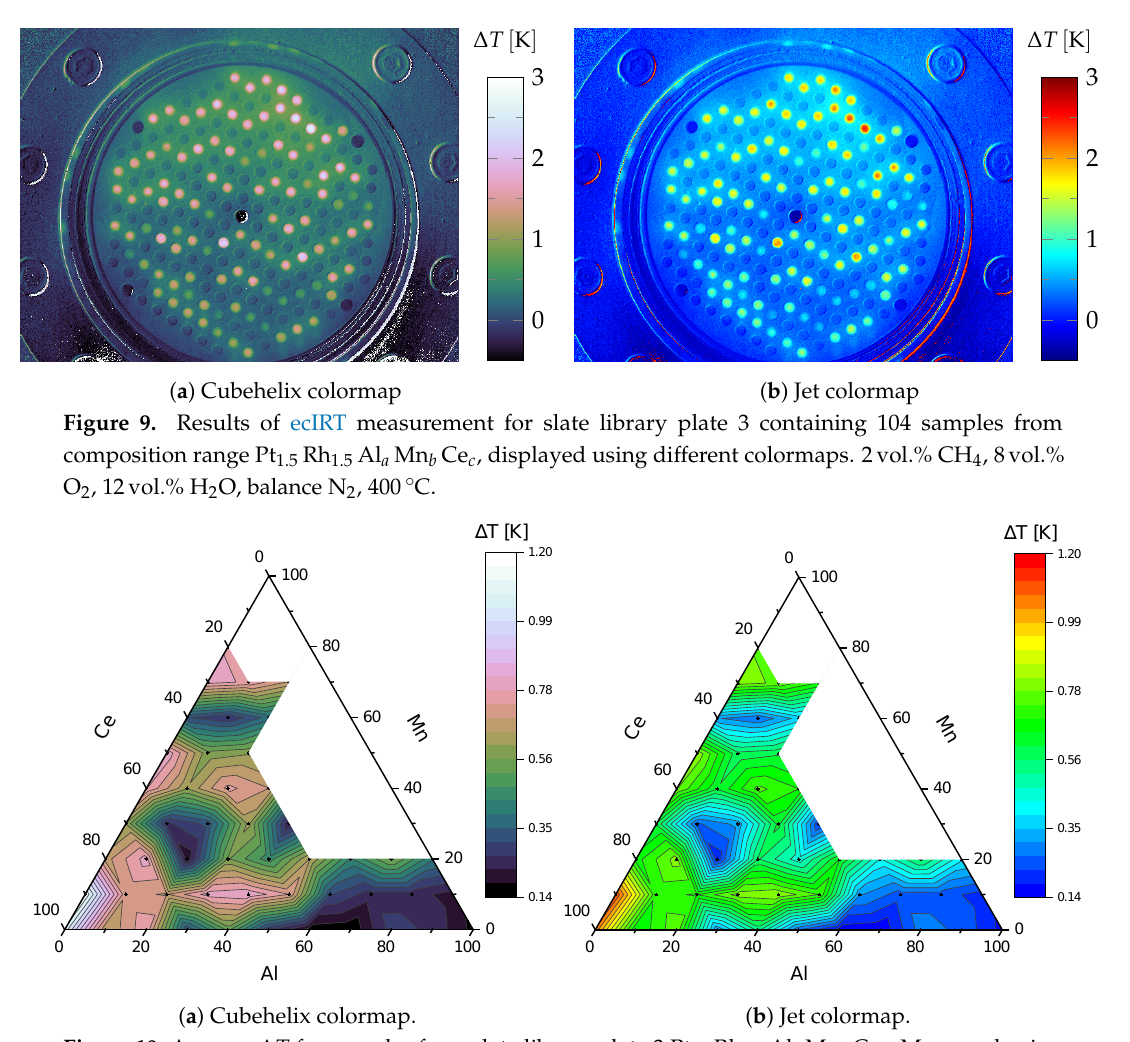
Figure 10. Average ∆ T for samples from slate library plate 3 Pt 1.5 Rh 1.5 Al a Mn b Ce c . Measured using ecIRT. Axis labels denoting the mole fraction χ of given element as percentage, e.g., Al representing χ Al = n Al , PMs are excluded from this calculation. Sample compositions are displayed by a n Al + n Mn + n Ce dot, values between dots are generated using linear interpolation. Table 3. Compositions of most promising materials from Figure 10, position on slate library, and average ∆ T